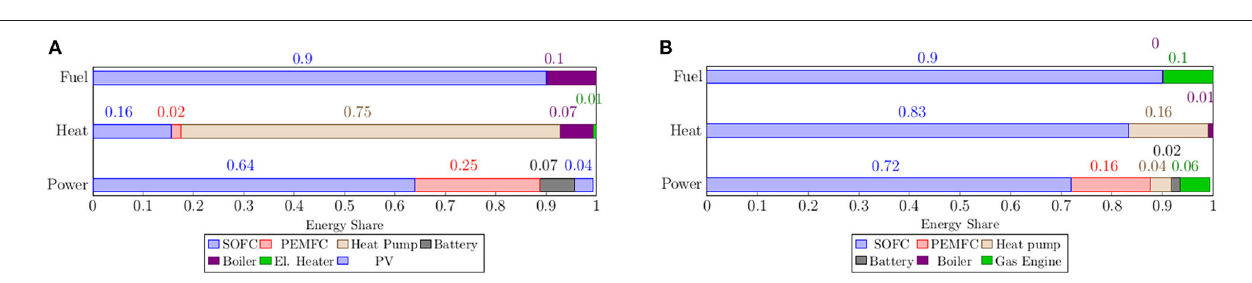
FIGURE 7 | Energy share among different utilities: Power generation, heat generation, fuel consumption. (A) Off-grid dwelling, (B) Cruise ship.